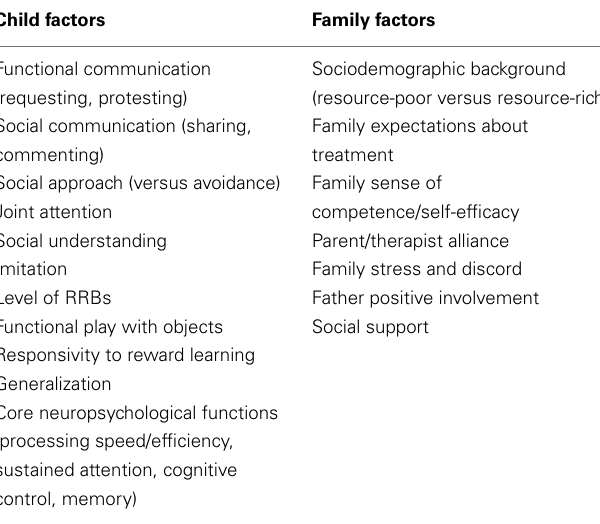
Table 1 | Putative predictors of treatment outcomes that require standardization/psychometric development